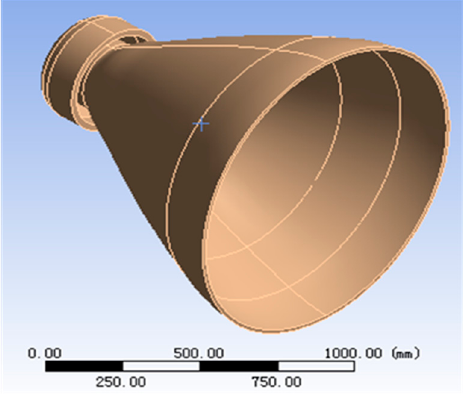
Figure 16. Nozzle model.